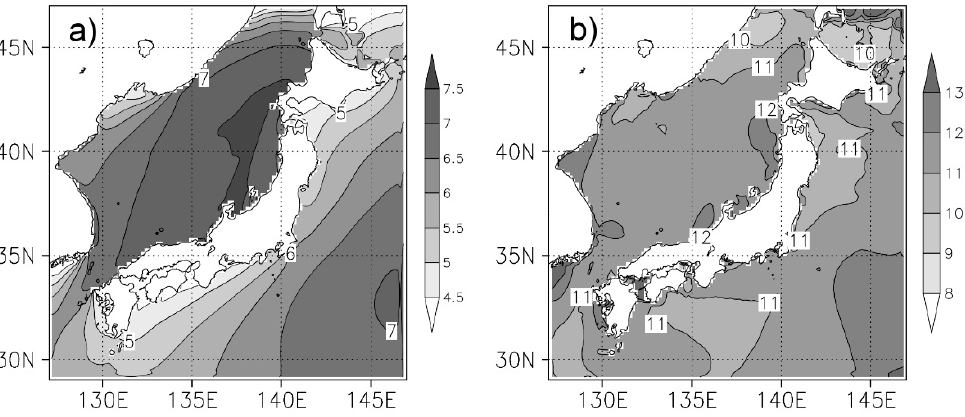
Figure 3. Results of H s for historical wave simulation by WW3. ( a ) Climatological mean H s ( H s ) for December–February (DJF) and ( b ) maximum H s ( H s_max ) during the target period (2000–2010). Unit of color bars is m.